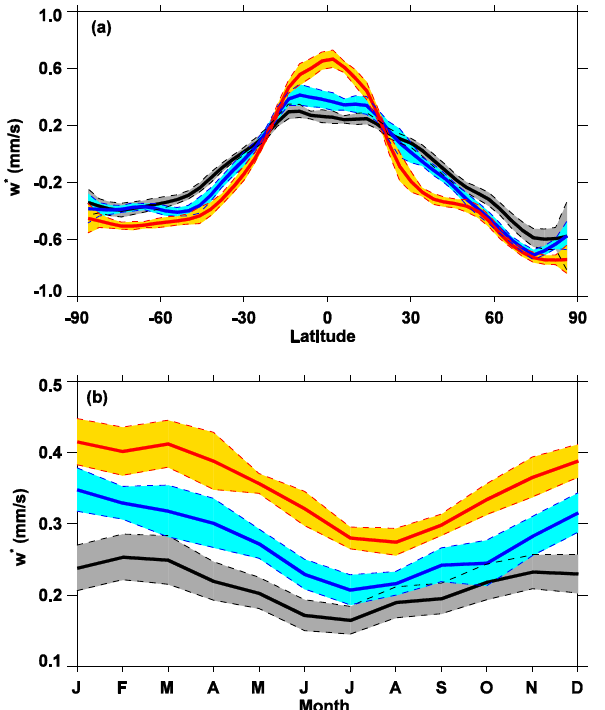
Fig. 3. Annual mean (a) and monthly mean (b) residual vertical velocities at 50hPa averaged over 30 ◦ S–30 ◦ N. The results are for the years 1987–2012 (black lines) and 2090–2100 (blue lines) of the reference run and for the years 2090–2100 of the noMPA run (red lines). The shading indicates standard deviations.